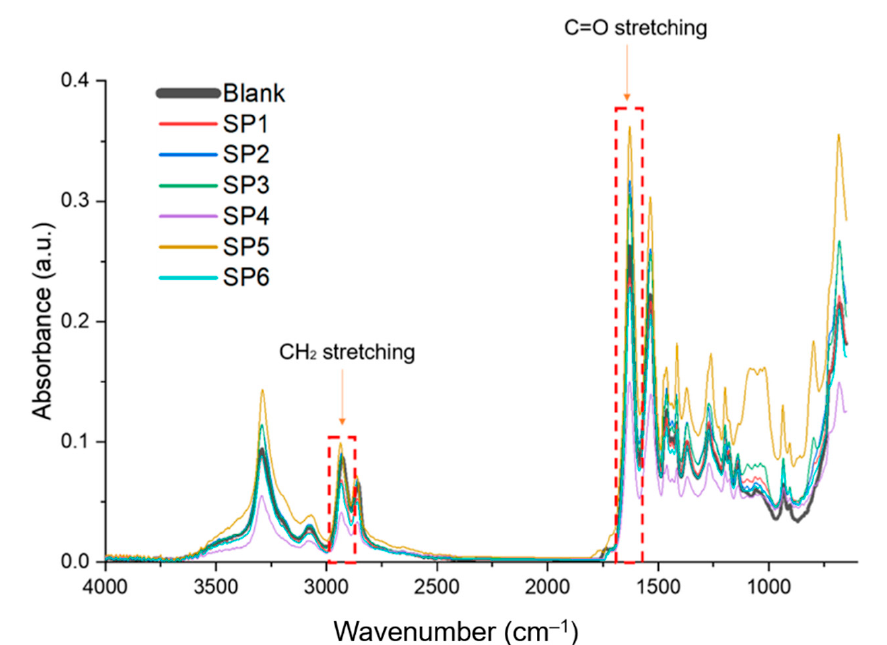
Figure 11. FTIR band assignment of PA66 microfibres unexposed to degradation mechanism. The band ≈ 1630 cm − 1 may correspond to the carbonyl group from amide groups (NH-C=O) and the reference peak selected was the most intense band from the CH 2 stretching. The reference blank was selected assuming that CH groups may undergo less oxidation and may remain constant [76].